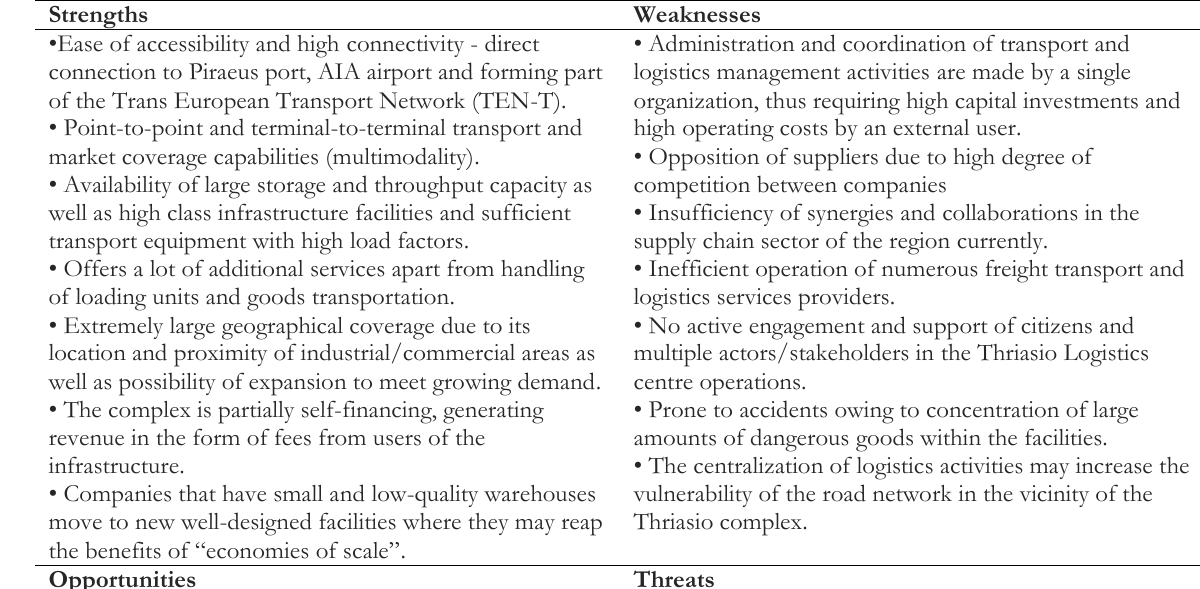
Table 8. SWOT analysis for thriasio logistics centre in